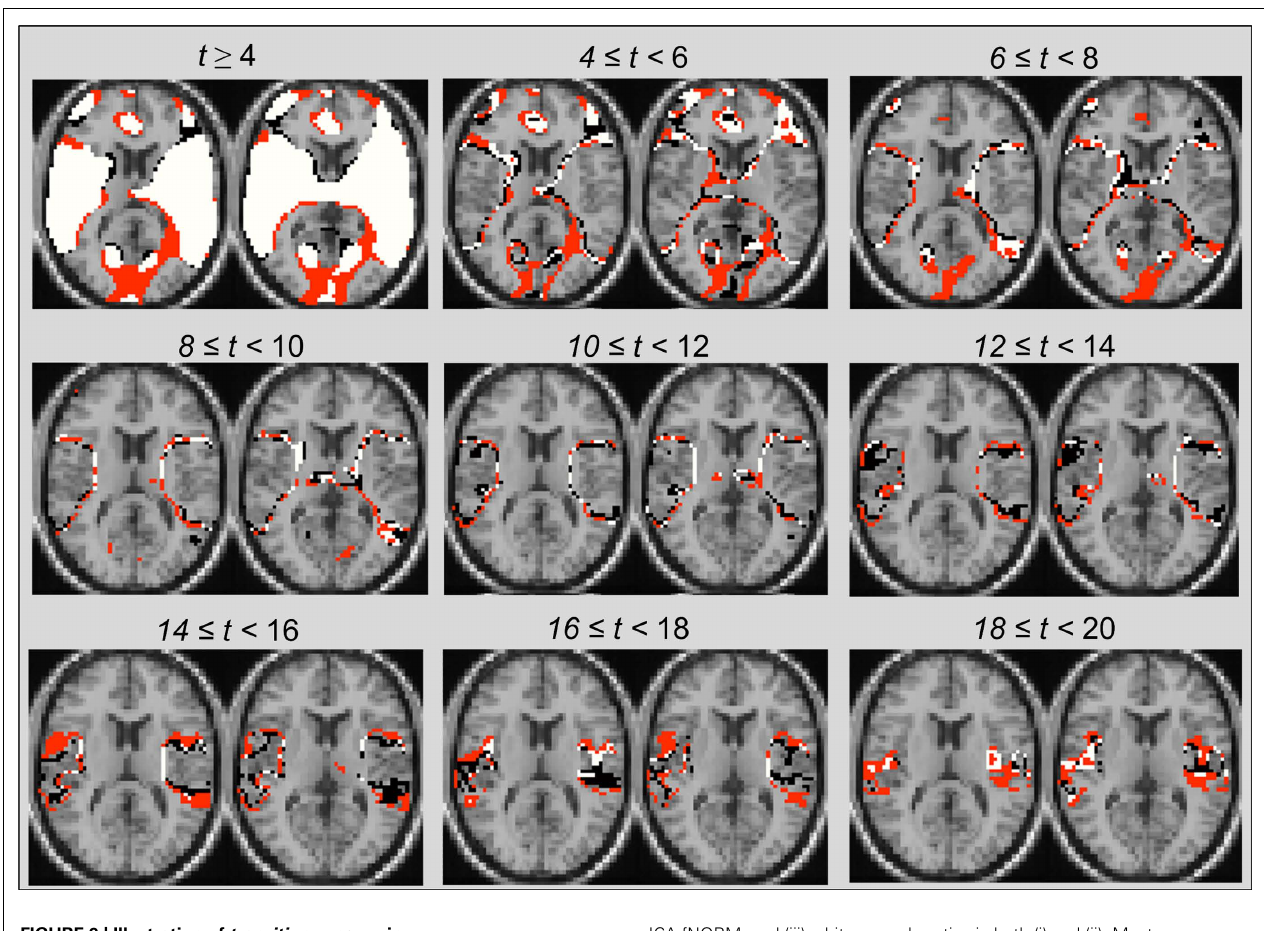
FIGURE 9 | Illustration of transition zones using range-thresholding of the primary task-positive component t -map obtained through group-ICA. All voxels are labeled based on the method – (i) “black”: Before ICA-fNORM, (ii) “red”: After